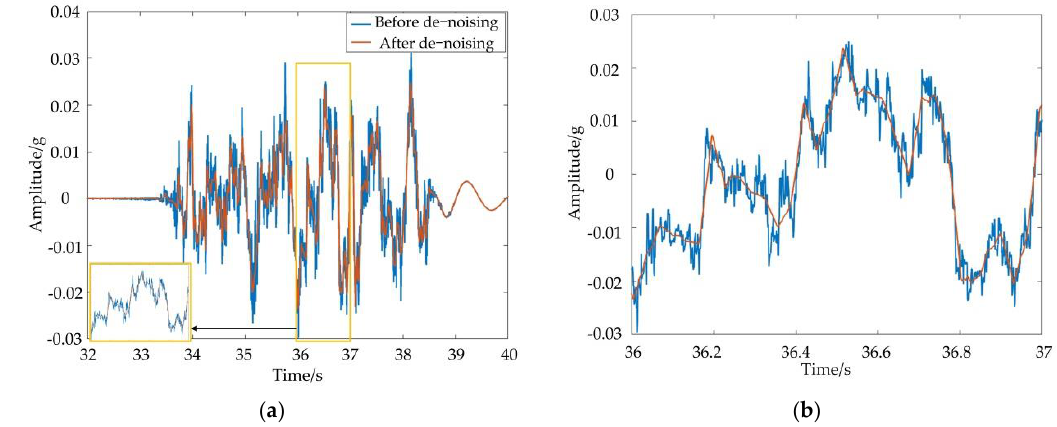
Figure 7. ( a ) Contrast between raw signal and de-noised signal. ( b ) Enlarged view of details.